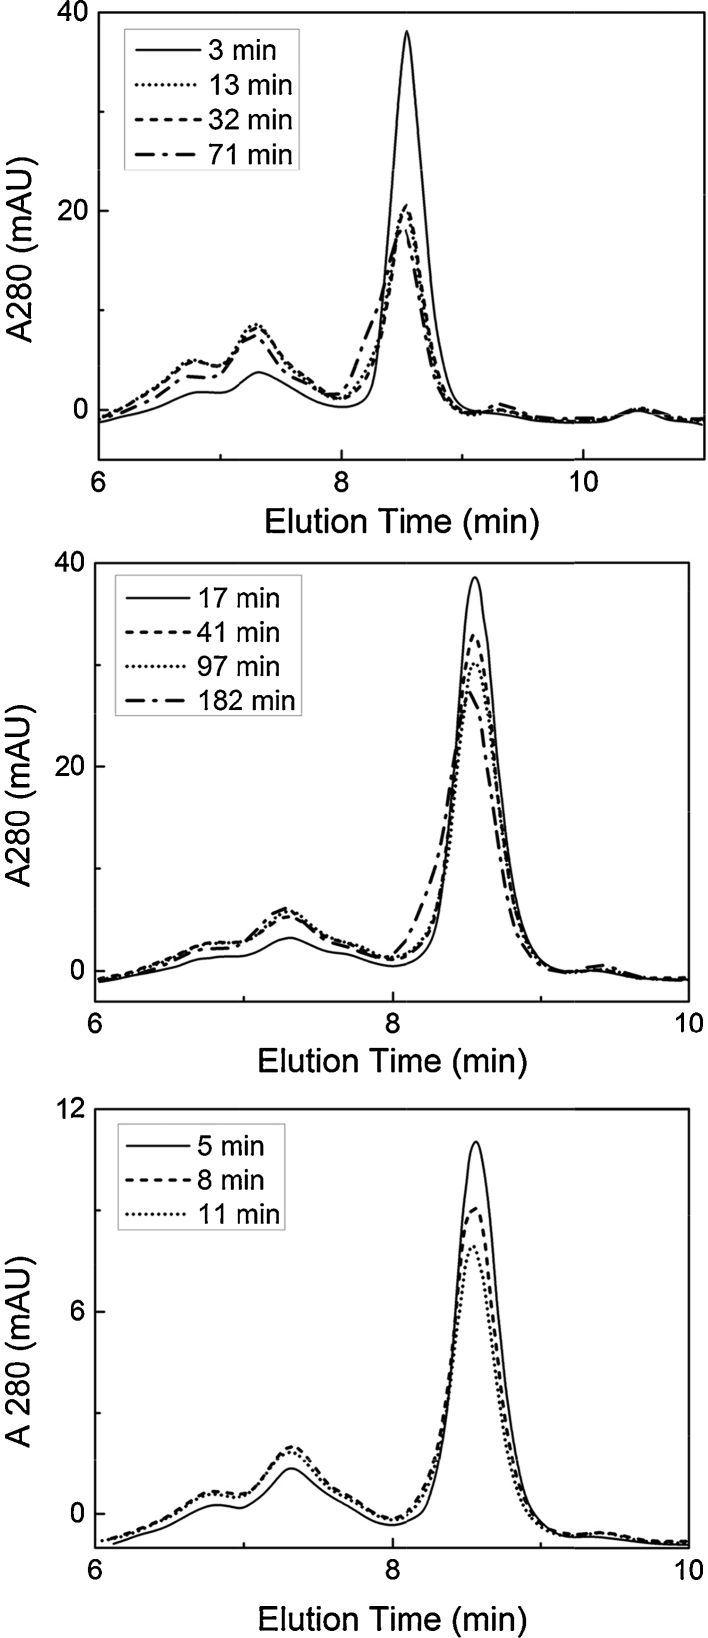
SEC chromatograms for IgG4 incubated under a range of low pH conditions. Top: pH 2.78 in solution. Middle: pH 3.05 after elution from column loaded with 12 mg IgG. Bottom: pH 2.92 after elution from column loaded with 25 mg IgG. Legends show incubation times to the nearest minute.